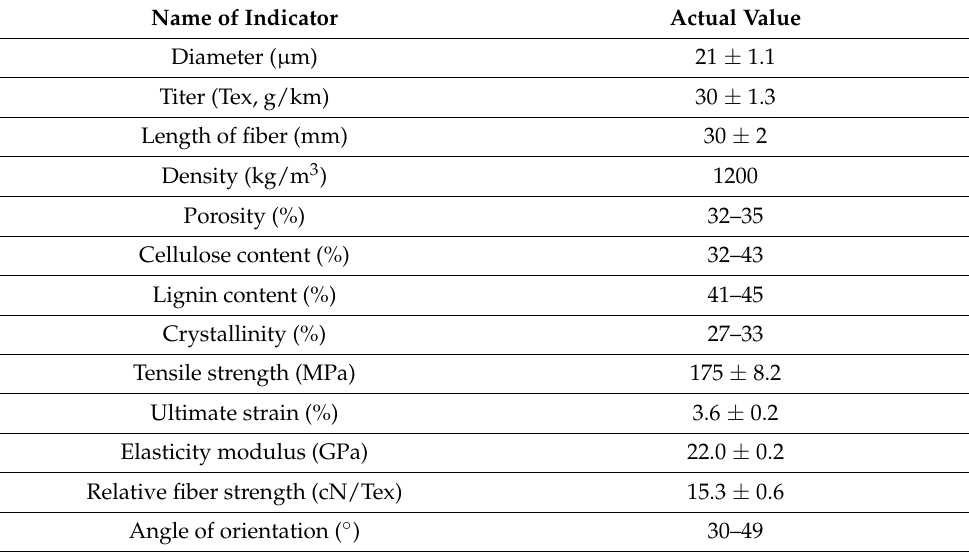
Table 3. Characteristics of coconut fiber.